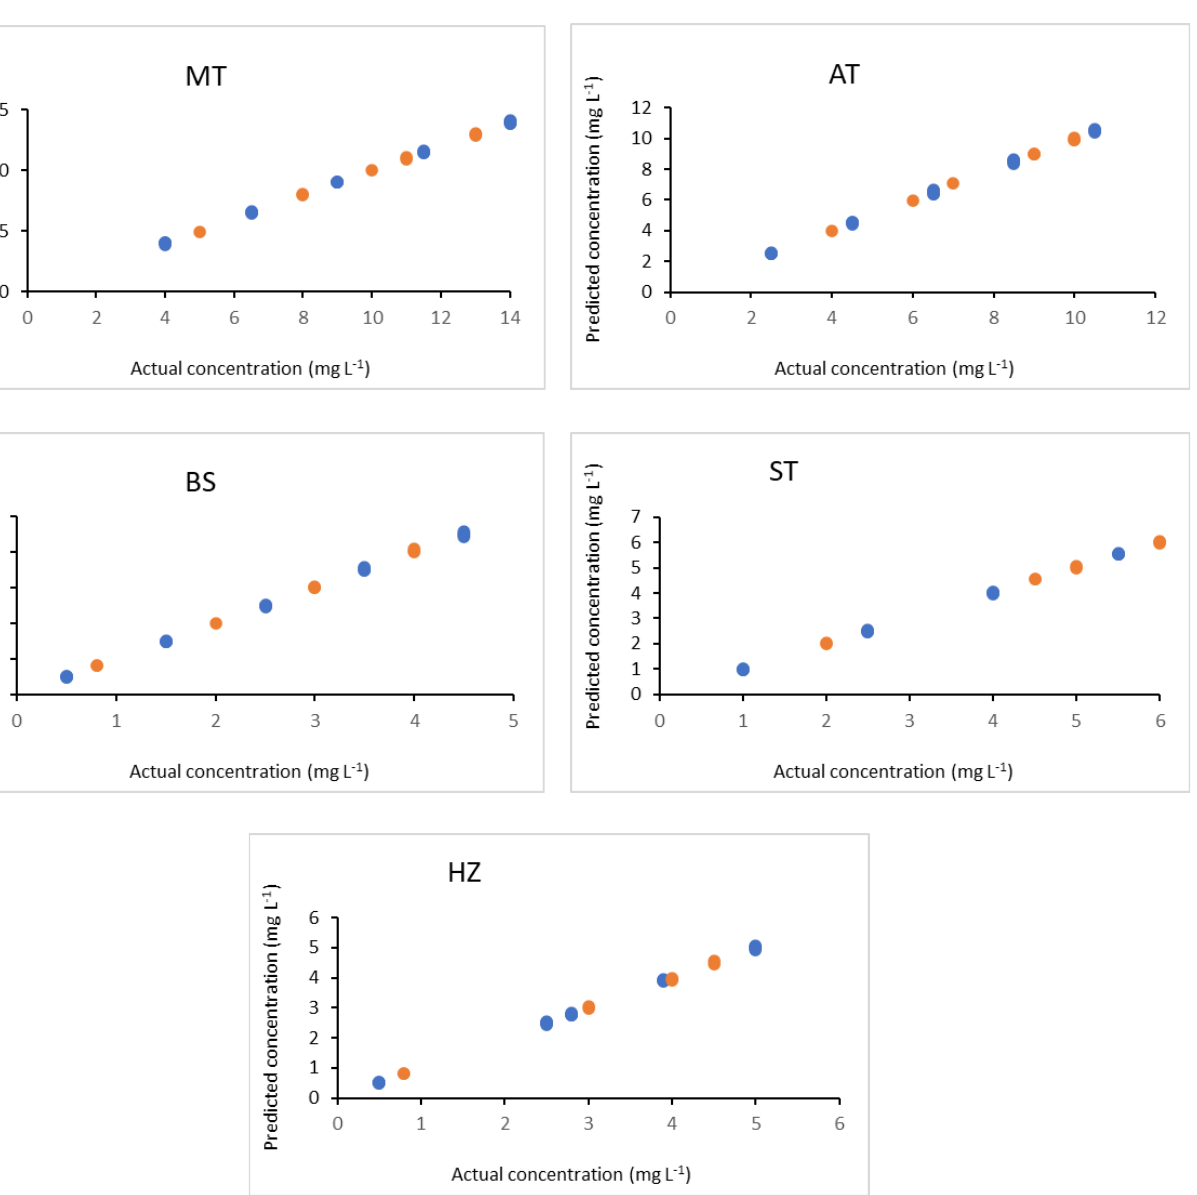
Figure 3. Plot of actual concentrations versus predicted values using PLSR for calibration set ( ) and validation set ( ) of the investigated drugs.